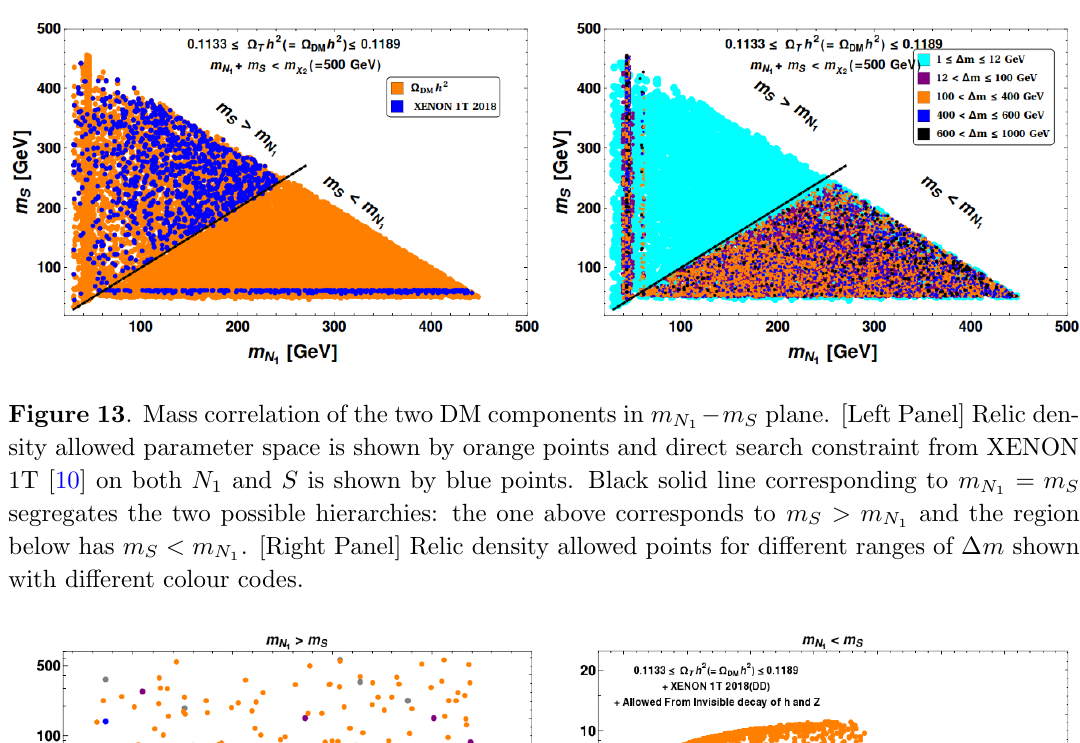
Figure 14 . Relic density, direct search (XENON 1T [10]) and invisible decay constrain of Higgs and Z boson [42] allowed parameter space of the two component model (with Y 2 plane. Percentage of fermion DM component in total relic density within di(cid:11)erent ranges are shown by di(cid:11)erent coloured points as detailed in the (cid:12)gure inset. Two di(cid:11)erent hierarchies m S < m N and m S > m N are shown separately in left and right panel 1